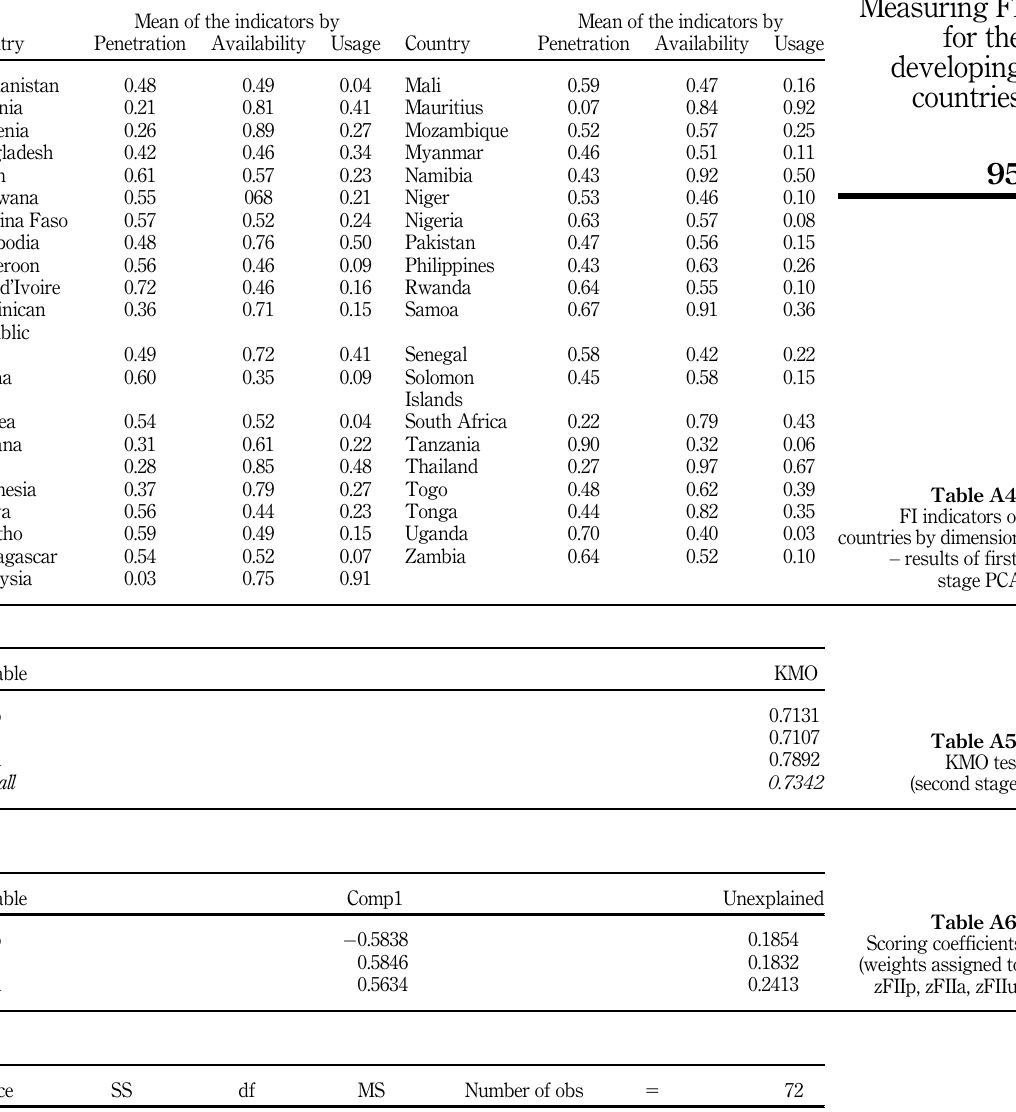
Table A7. Regression